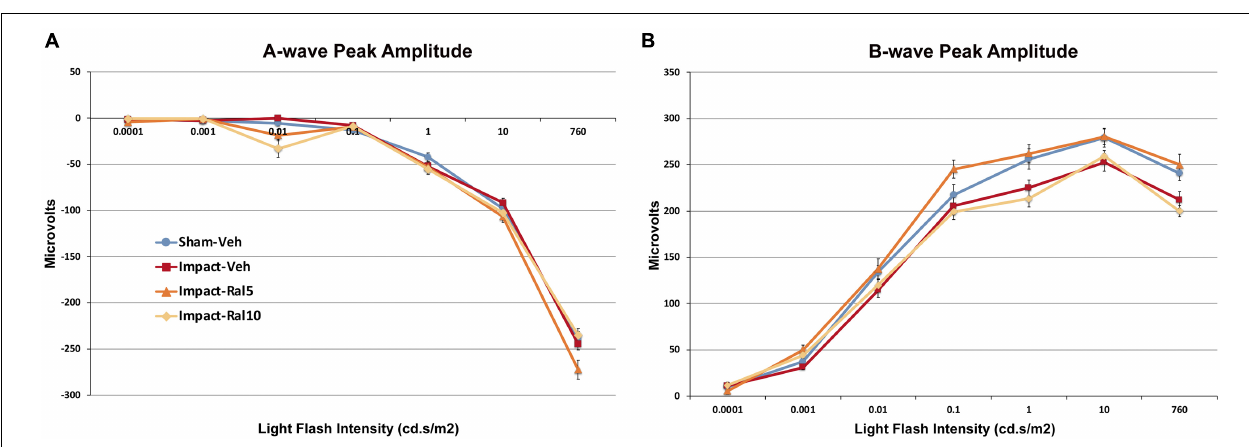
10 mg/kg raloxifene rescued the pupillary defect (i.e.,